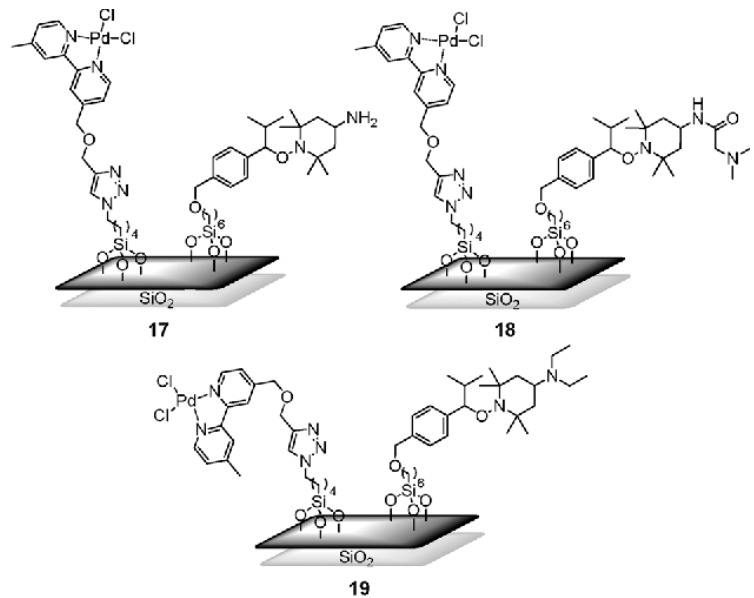
Figure 20. MSNs 17 – 19 bearing bipyridyl complexed Pd. Reproduced with permission from [28]. Copyright 2013 Royal society of Chemistry.